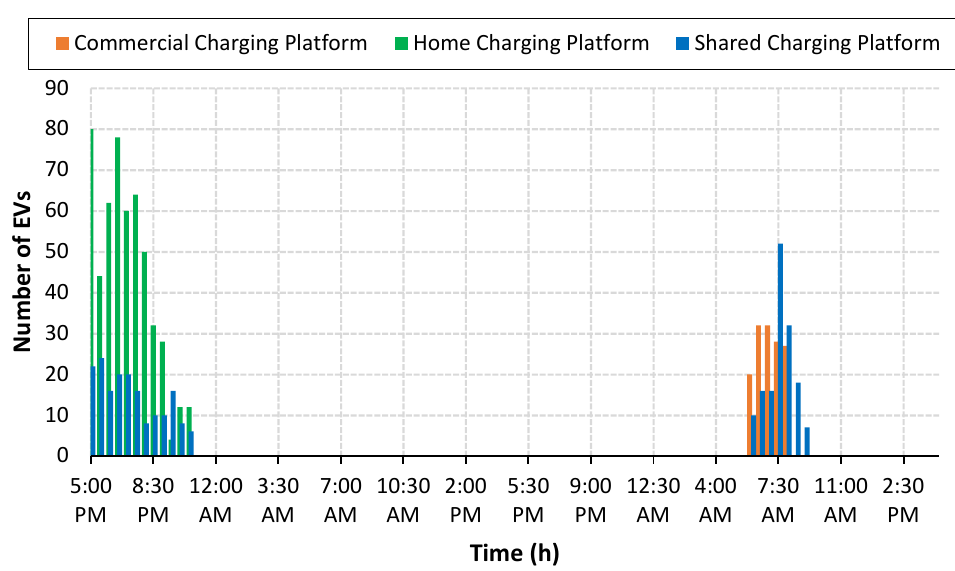
Figure 6. EV arrival at different charging platforms .